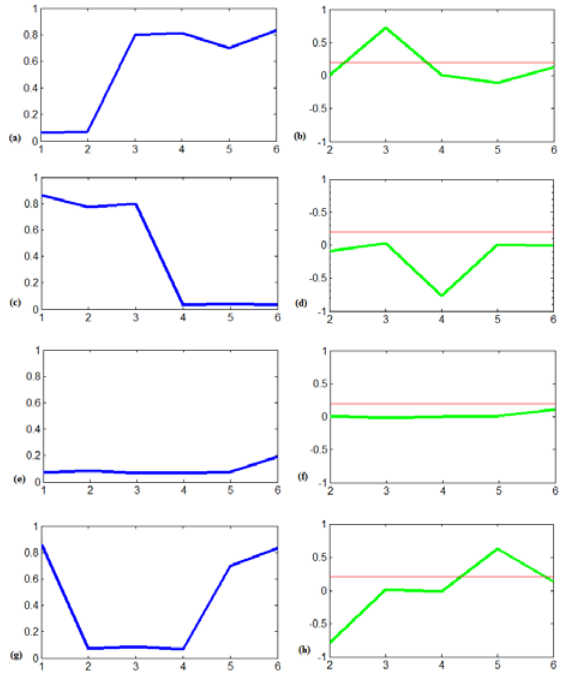
Figure 4. Evolution in time for the probability of a pixel to belong to a building: (a) newly built building; (b) FD of (a); (c) demolished building; (d) FD of (b); (e) unchanged ground; (f) FD of (e); (g) rebuilt building; (h) FD of (g).